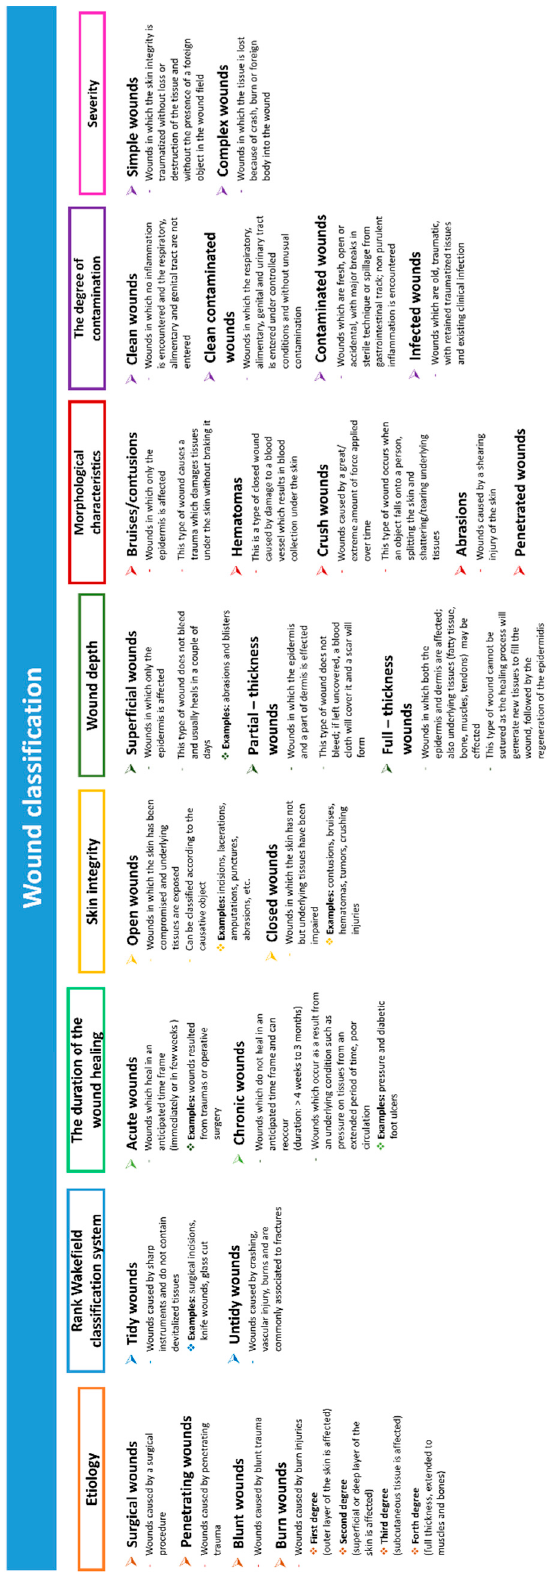
Figure 1. Wound classification.